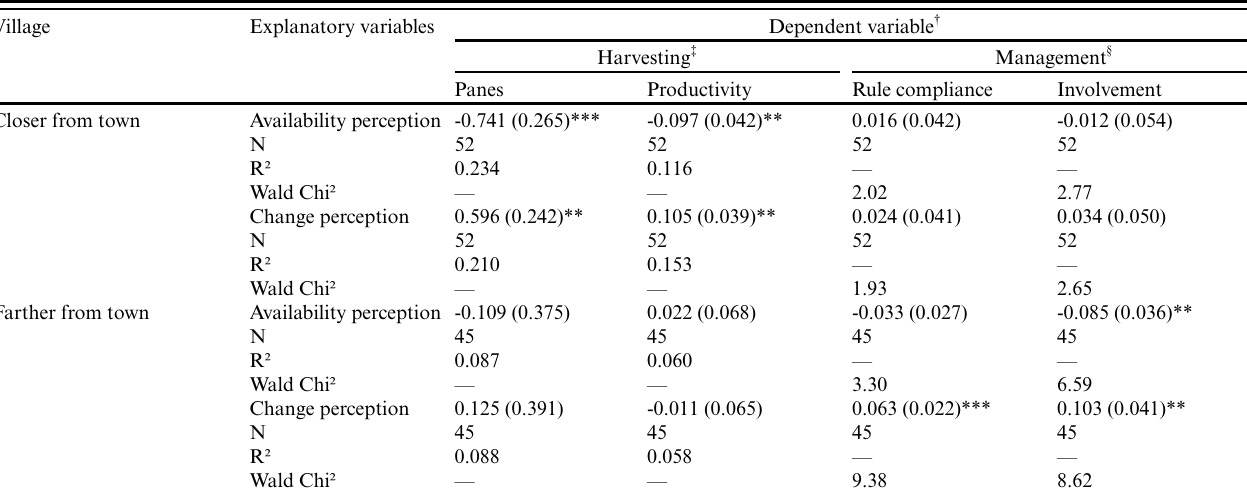
Table 5 . Results of ordinary least-square and Poisson multivariate regressions of different individual harvesting and social behavior variables against individual perceptions of Geonoma deversa availability and